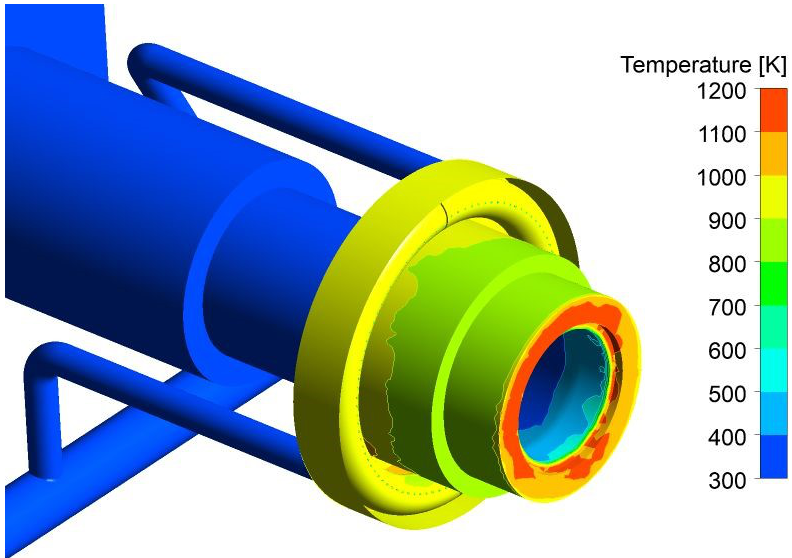
Figure 18. Temperature contour profile on burner tile.